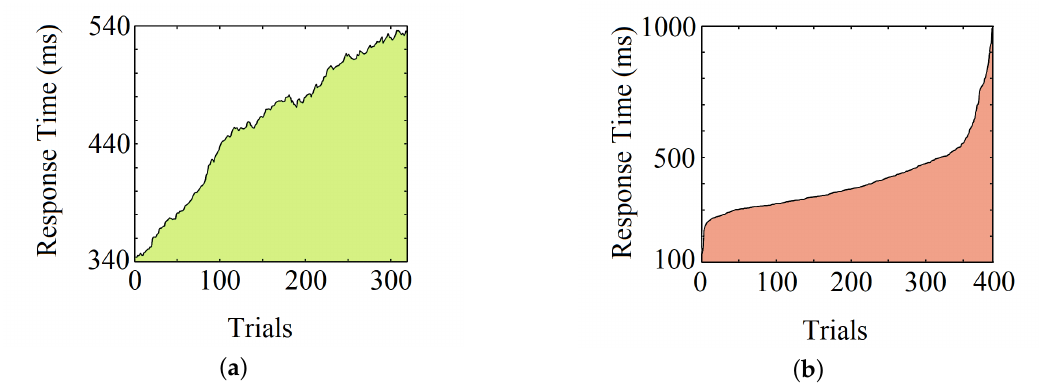
Figure 9. Observation of an individual RT after ( a ) the moving average operation and ( b ) the sorting operation.